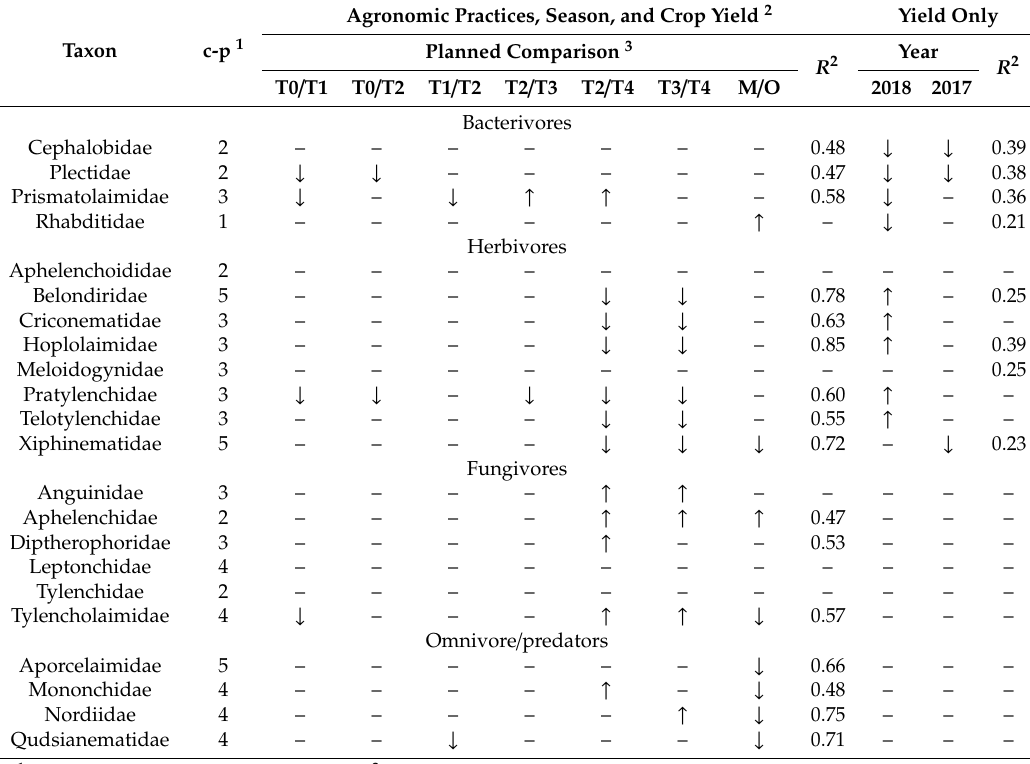
Table 4. Response of given nematode taxa abundance to agronomic practices, season, and crop yield (from two multivariate